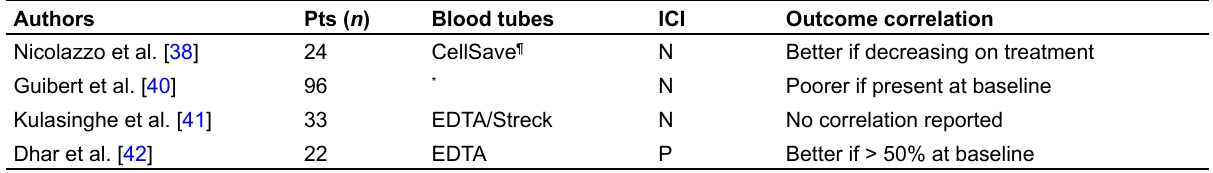
Table 1. Reported studies on PD-L1(+) CTCs in